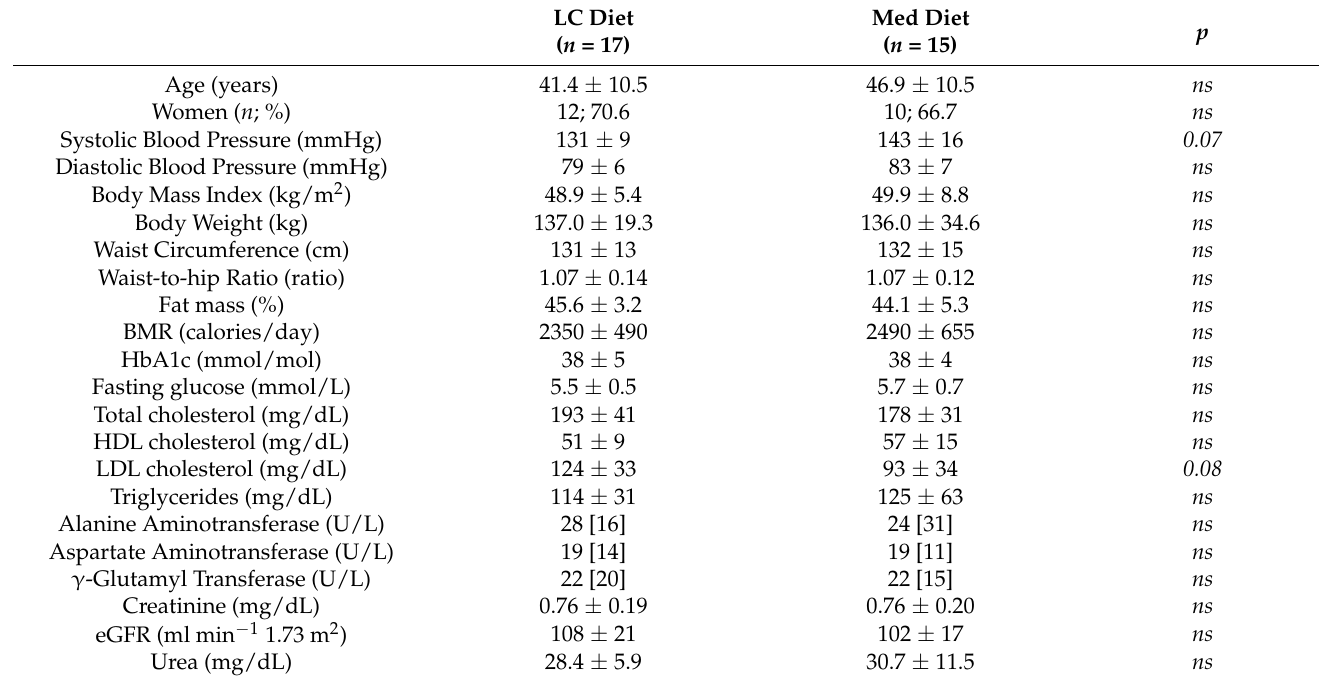
Table 1. Baseline clinical and metabolic characteristics of morbidly obese individuals randomized to a low-carbohydrate diet (LC) or Mediterranean (Med)